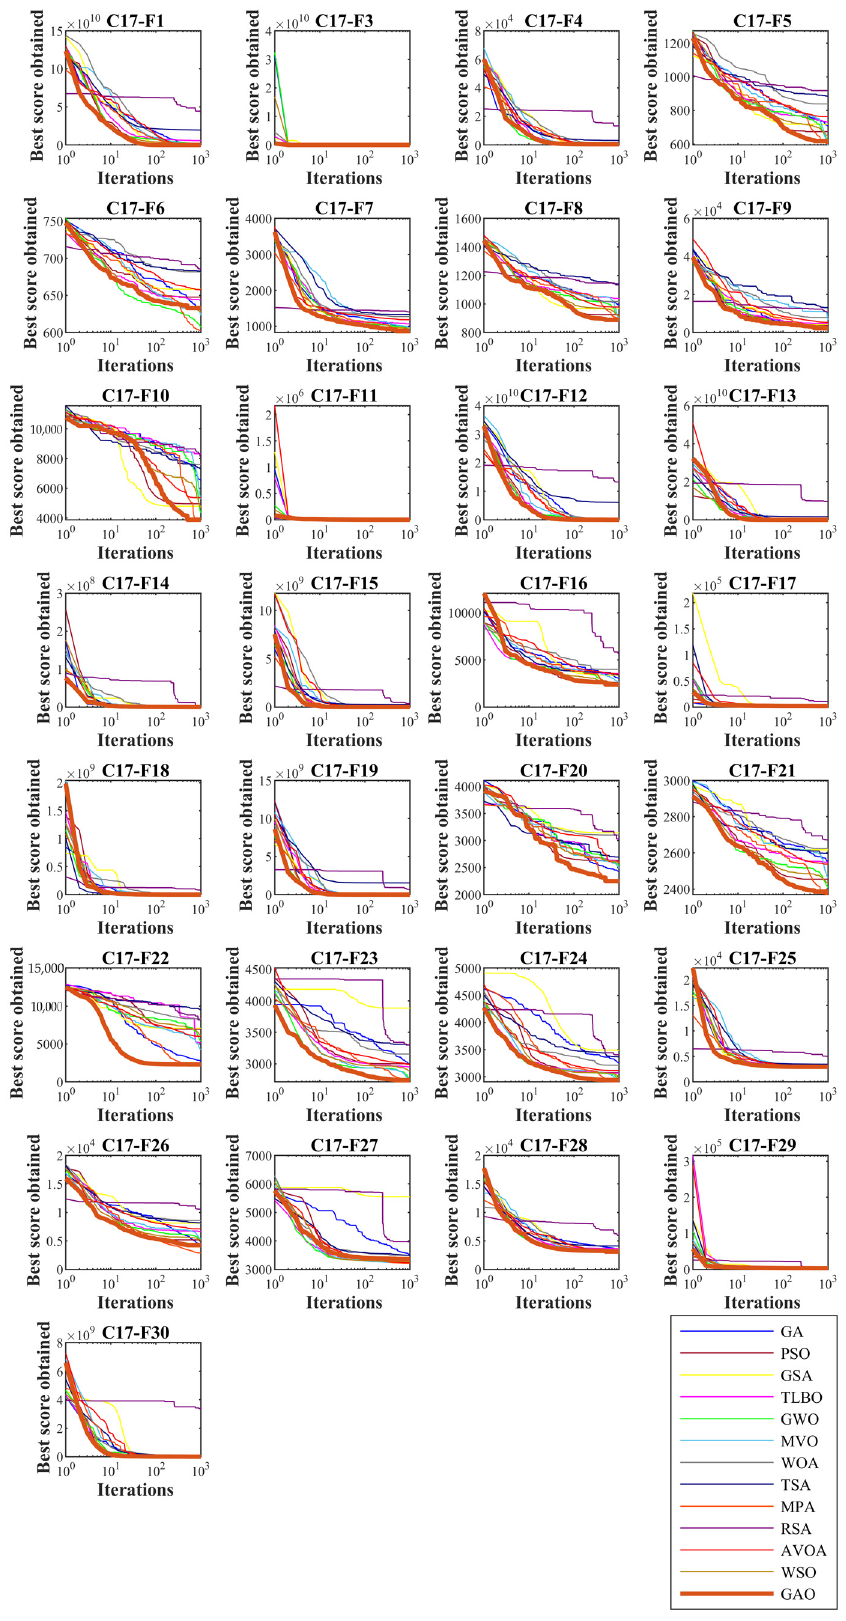
Figure 4. Convergence curves of GAO and competitor algorithms performance on the CEC 2017 test suite (dimension 𝑚 = 30 ).